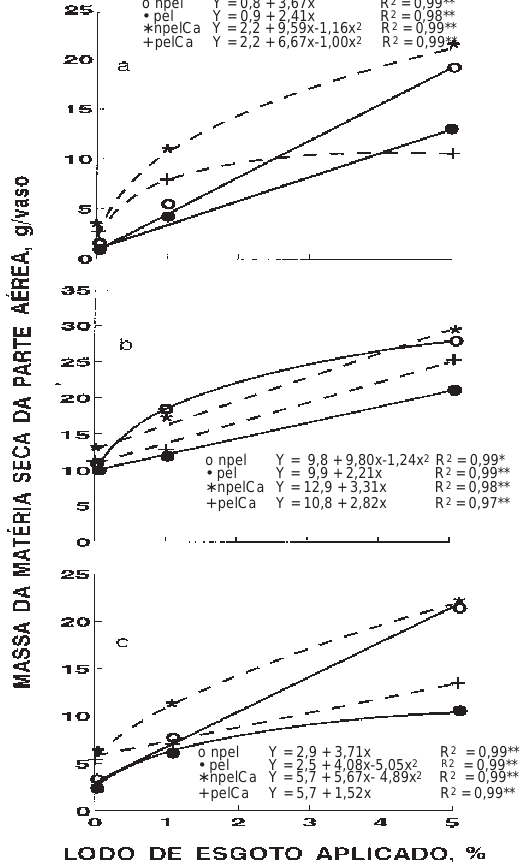
Figura 1. Produção de matéria seca pela parte aérea do milho em resposta à adição de lodo de esgoto, peletizado ou não, com ou sem CaCO 3 , em três solos: a) LE, b) LR e c) LV. npel = não peletizado; pel = peletizado; npelCa = não peletizado e com CaCO 3 ; pelCa = peletizado e com CaCO 3 .